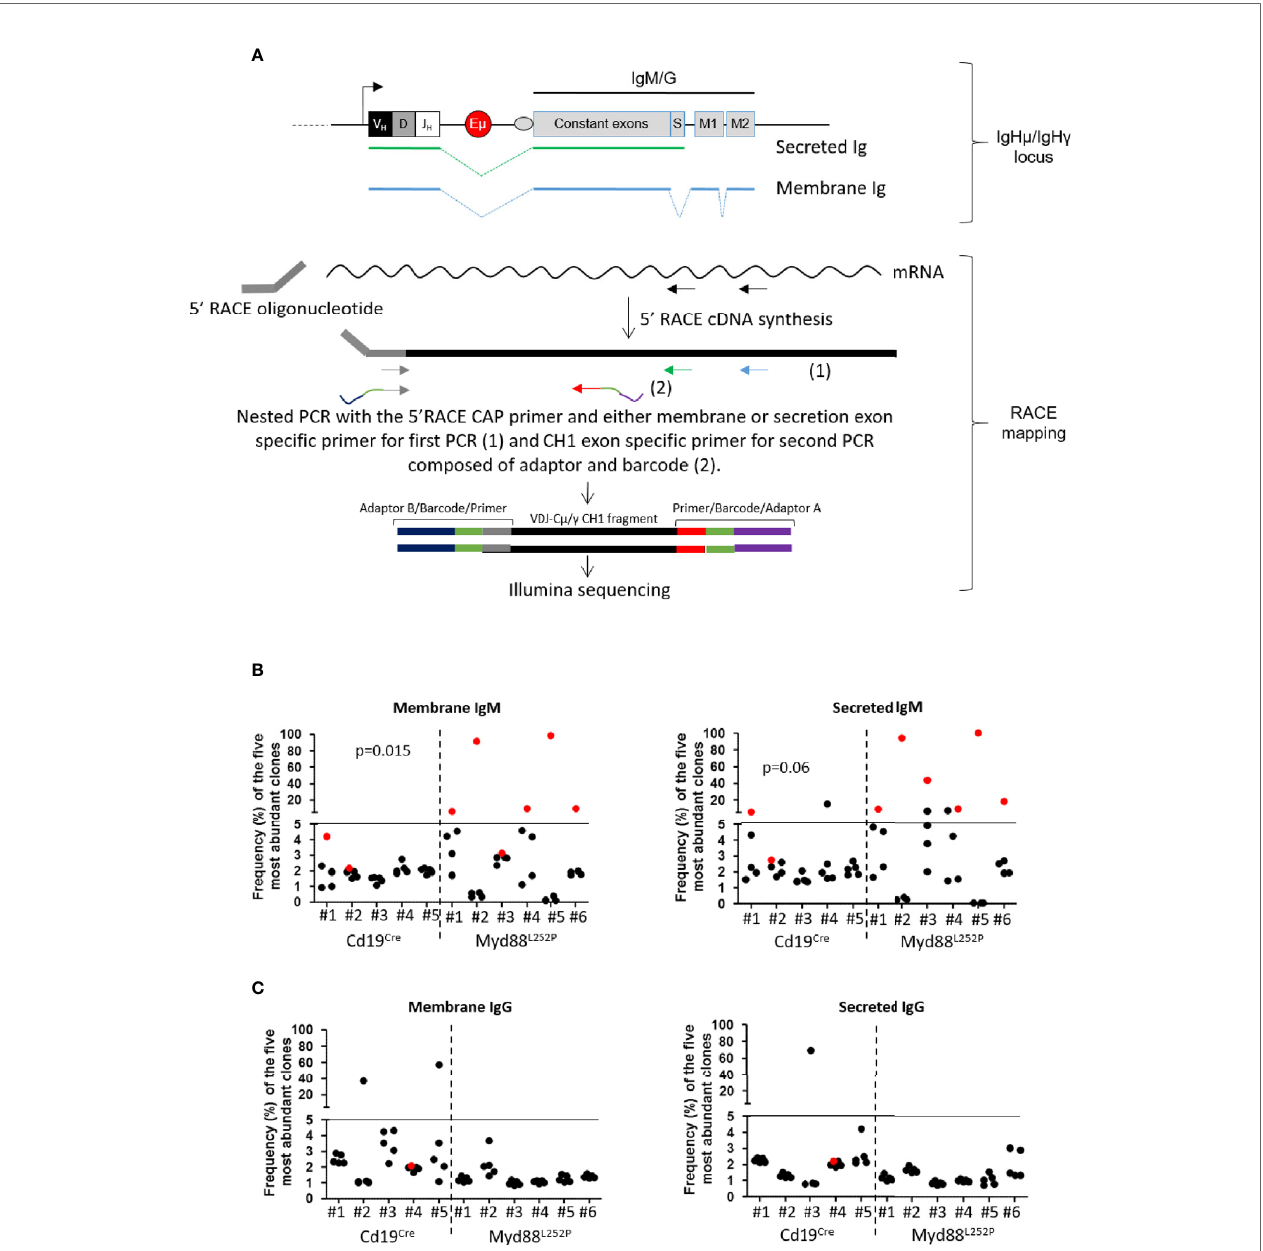
FIGURE 8 | µ and g heavy chain mRNA clonal abundance: (A) RACE PCR technique quantifying clonal mRNA abundance of membrane and secreted forms of mouse µ and g heavy chains. Igh m /Igh g locus (upper panel): Igh locus with variable regions (VDJ), the enhancer Eµ and constant genes (for IgM or IgG). Box “ S ” represents the secreted exon used for the secreted form of Ig, “ M1 and M2 ” represent the membrane exons for the membrane form of Ig. Green or blue dotted lines show RNA splicing respectively for secreted and membrane Ig. RACE mapping (lower panel): 5 ’ RACE PCR followed by preparation of libraries for Illumina sequencing. First, we ampli fi ed cDNA between the primer speci fi c for the membrane or the secreted form (black arrows) and the 5 ’ RACE oligonucleotide. Amplicons for Illumina sequencing were obtained after two nested PCRs; the fi rst with the 5 ’ Race CAP primer and either membrane (blue arrow) or secretion (green arrow) exon speci fi c primer, and the second with the same 5 ’ primer and a CH1 exon speci fi c primer (grey arrow). For sequencing, forward (grey) and reverse (red) primers used for the second PCR contained adaptors (blue and purple) and a barcode (orange); each barcode sequence was speci fi c for one sample only. (B, C) Relative frequency of the fi ve most abundant mRNA clones coding for membrane (left) and secreted (right) forms of µ (B) and g (C) heavy chains for Cd19 Cre (n = 5) and Myd88 L252P (n = 6) mice. The most abundant clones are highlighted in red when VDJ sequences of the dominant membrane and secreted clones were identical. Myd88 L252P mice exhibited IgM but not IgG clonal expansion with expression of both secreted and membrane form of the µ chain. Wilcoxon ’ s test p-value are given in the fi